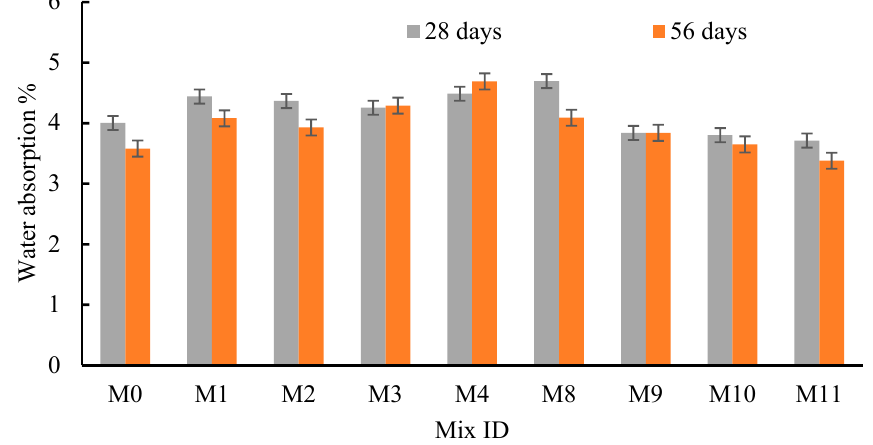
Figure 14. Effect of RFCA and RFNA on the water absorption of concrete.